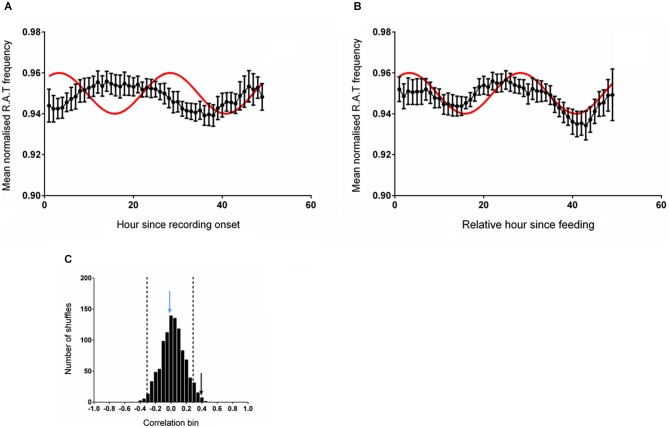
(A) The mean (±sem) normalized RAT frequency data obtained when individual recordings are referenced to entry into the recording apparatus, but not the time of feeding, are not correlated with the reference sine shown in red. (B) When the individual RAT frequency data are shifted such that they are referenced to the time of feeding (6 pm solar time), the mean data are significantly correlated with the reference (p < 0.05). Data are smoothed using a 5-point moving average for these illustrations only. (C) illustrates the frequency distribution produced when 1000 shuffled versions of the dataset are generated and correlated against the reference sine. The vertical dashed lines demark two standard deviations from the mean of the distribution. The vertical blue arrow denotes the magnitude of the correlation of the dataset shown in (A) and the vertical black arrow denotes the magnitude of the correlation of the dataset shifted relative to a feeding reference in (B).